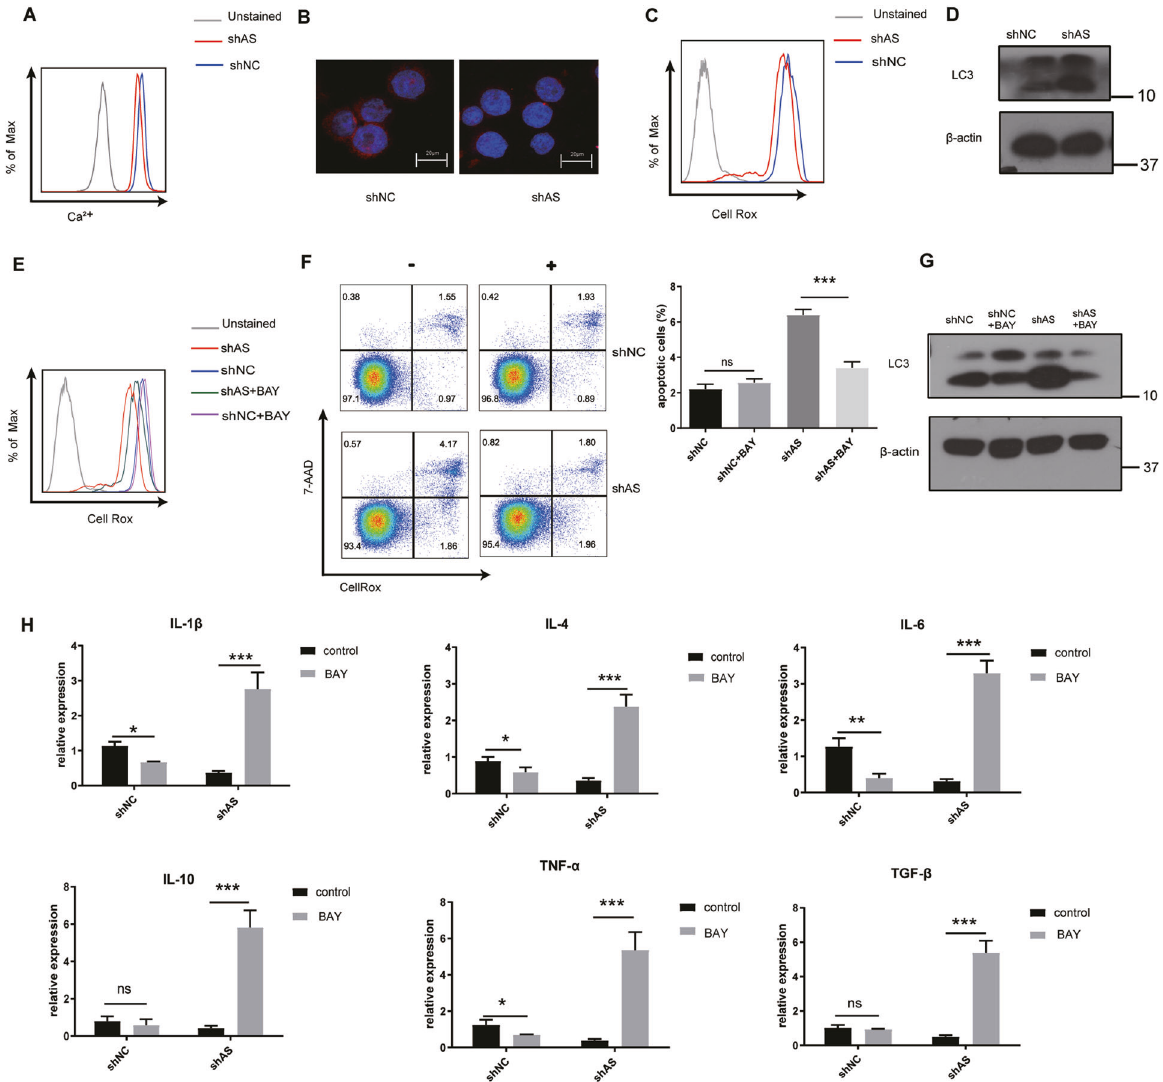
Fig. 5 LncTRPM2-AS modulates macrophage apoptosis and cytokine production by regulating calcium levels. A Calcium and C ROS levels were detected by fl ow cytometry. B The density of calcium in a single shAS cell and shNC cell was detected by Confocal laser scanning microscopy. D Detection of LC3 protein in shNC and shAS cells by Western blotting. E ShNC and shAS cells were treated with a fi nal concentration of 10 μ M calcium activator BAY-K-8644 and the levels of ROS, F apoptosis, G LC3 protein, or H cytokines including IL-1 β , IL-4, IL- 6, IL-10, TNF- α , and TGF- β , were detected. Bars, ± SD; n = 3, ns not signi fi cant; * P < 0.05; *** P <